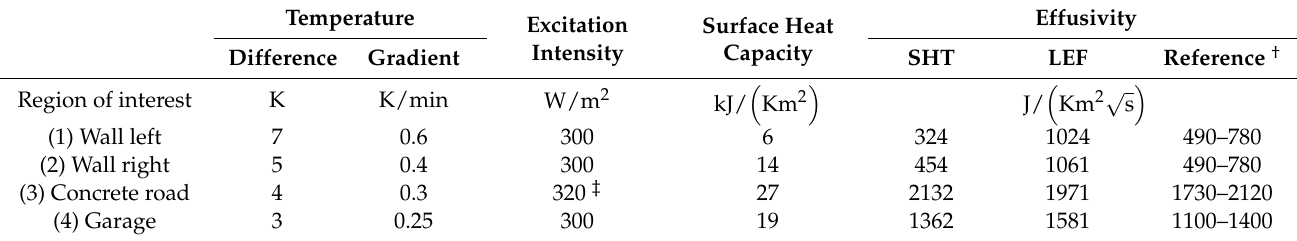
Figure 3. Optical overview over the scene. Table 1. Overview of the different estimations. Note this table corrects for the albedo factor of the different image parts. † The reference values are taken from [14–16] ‡ as the concrete road lay horizontally. GHI is the excitation intensity (see Figure